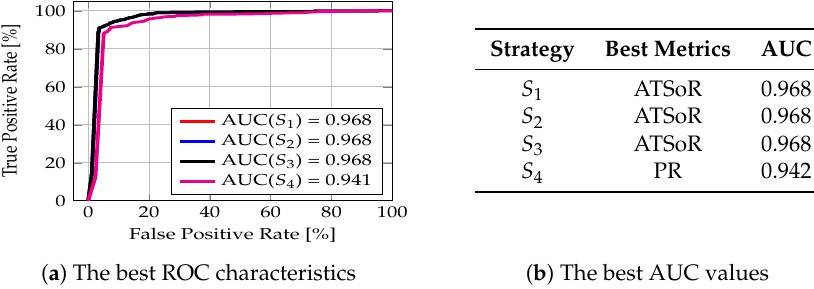
Figure 12. The best AUC values ( b ) and best ROC curves characteristics ( a ) for attribute Name .